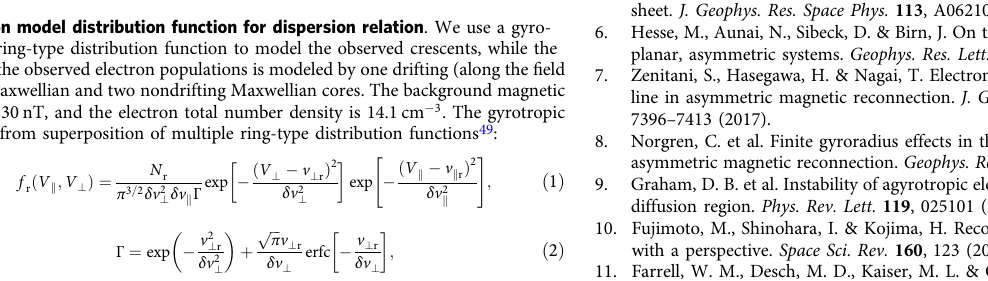
where erfc is the complementary error function. The parameters, number density ( N r , in cm (cid:1) 3 ), parallel and perpendicular thermal speeds ( δ v k and δ v ? ,